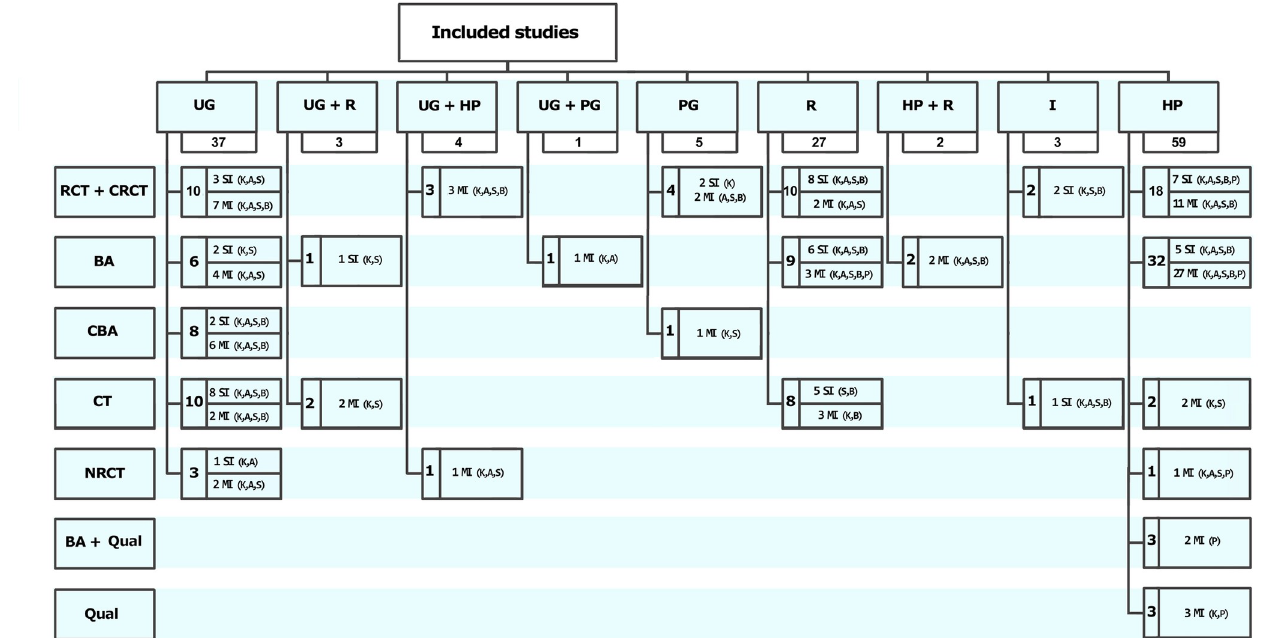
Fig 3. Summary of source studies included in the systematic reviews. A–attitudes, B–behaviour, BA–before and after study, CBA–controlled before and after study, CRCT- cluster RCT, CT- controlled trial, HP–health professionals, I–interns, K -knowledge, MI–multiple intervention, NRCT–nonrandomised controlled trial, P–practice, Qual–qualitative study, R–residents, RCT–randomised controlled trial, S–skills, SI–single intervention, UG–undergraduates.